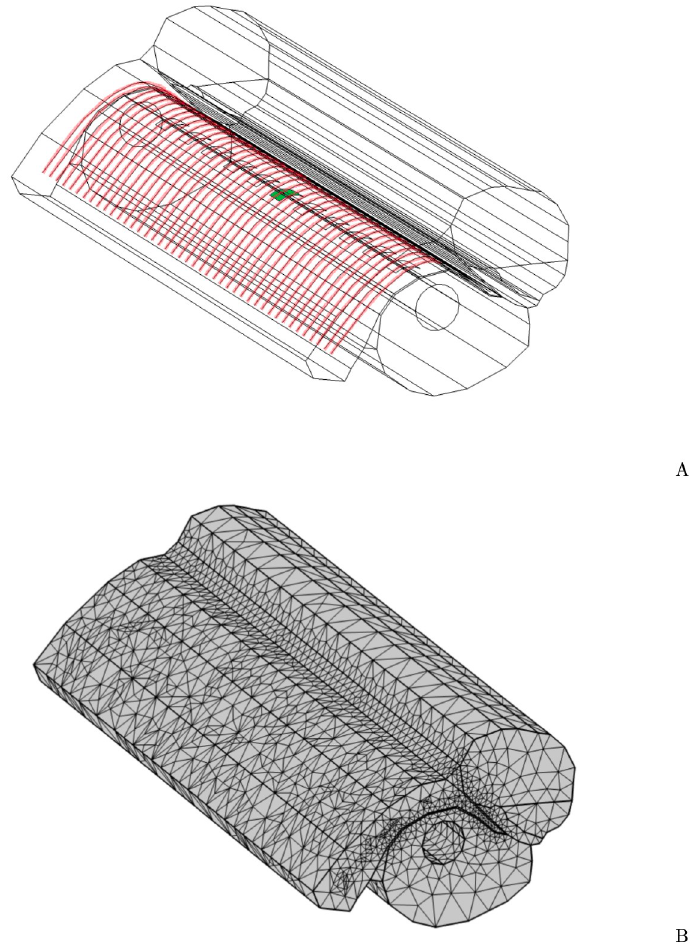
Fig 3. Electrode array and virtual neurons. Straight section of the cochlea containing the half banded electrode array and the virtual neurons. The stimulating electrode is shown in green and the virtual neurons are shown in red (A). Surface mesh with a refinement around the VN